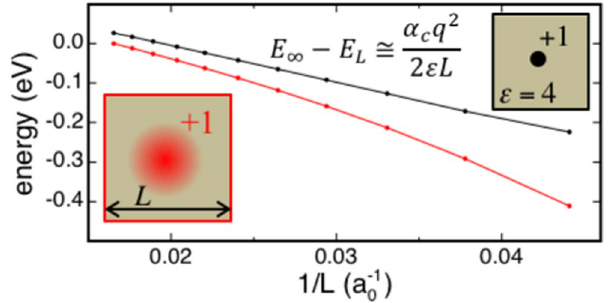
Figure 3. Energy vs. L − 1 of a cubic array of (black discs) unit point charges and (red discs) a unit Gaussian charge of width 2 Å in a model dielectric material with a permittivity of 4. For clarity, schematics of the defected supercells and energy scaling function are shown as insets.